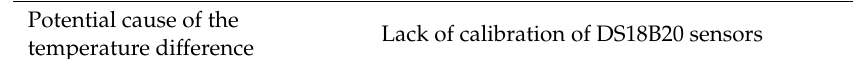
Table 5. Borehole 1. Temperature comparison between the two sensor types. Sensor Type